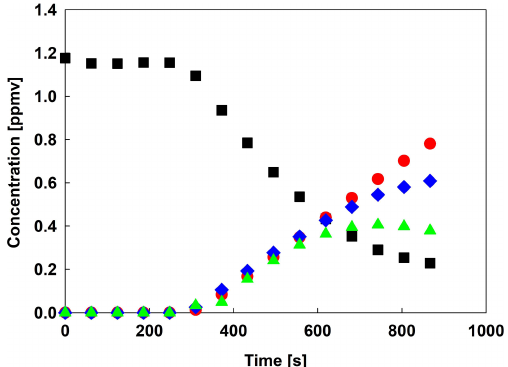
Figure 4. Concentration–time dependencies for the reaction of TMBO ( ) + OH radicals and the quantified products, methyl formate ( MF), peroxyacetyl nitrate ( PAN) and methyl glyoxal (